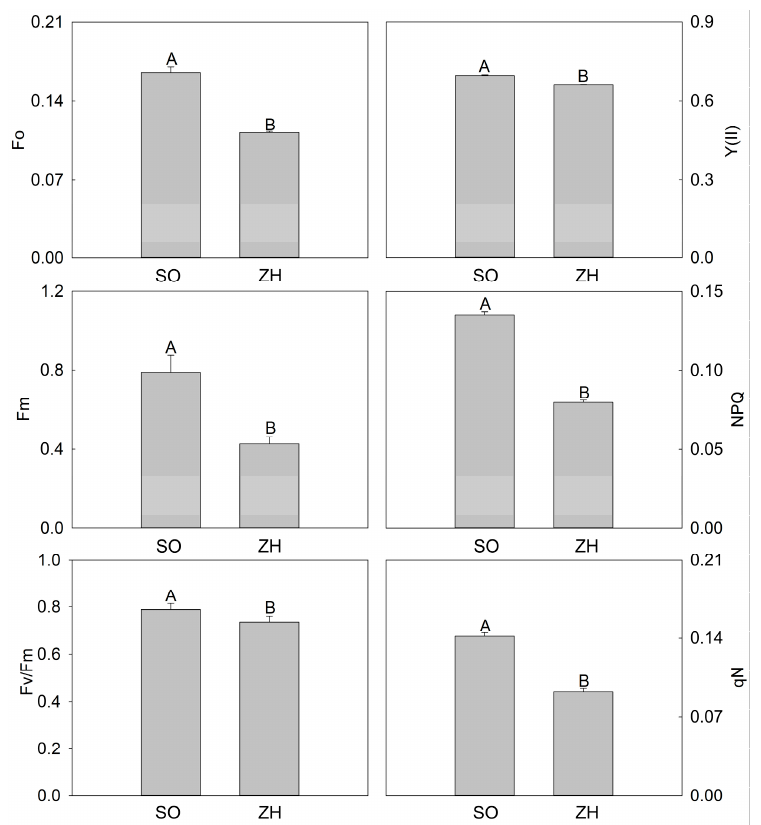
Figure 4. Chlorophyll fluorescence parameters of ‘SO’ and ‘ZH’. The values represented the mean ± SD, and different letters indicate very significant differences according to Duncan’s multiple range test ( P < 0.01).